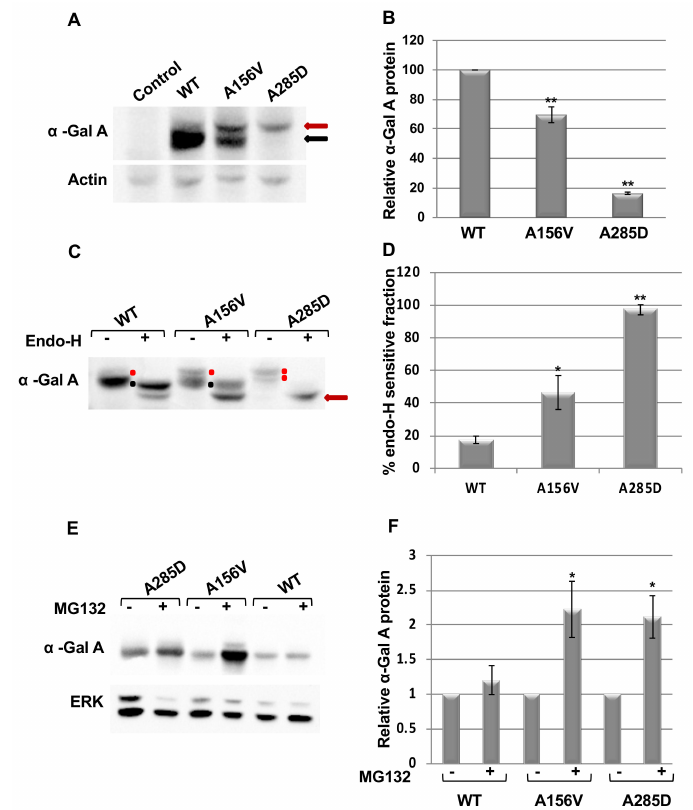
Figure 1. Alpha-Gal A expression in Drosophila melanogaster . ( A ) Lysates prepared from 15 day old flies were subjected to sodium dodecyl sulphate polyacrylamise gel electrophoresis (SDS–PAGE) and interaction with anti-Myc antibody, to identify α -Gal A and anti actin antibodies, as a loading control. The red arrow indicates the higher molecular weight, endoplasmic reticulum (ER) retained fraction of the protein; the black arrow indicates the lower molecular weight lysosomal fraction of the protein. ( B ) Quantification of results as seen in A of three independent experiments (mean ± standard error of mean (SEM)). To quantify the results, α -Gal A intensity in each lane was divided by that of actin in the same lane, and the number obtained for wild type (WT) was considered to be 100. Statistical analysis included one-way ANOVA followed by one-sample t-test. ( C ) Lysates prepared as in A were treated with endo-H and analyzed by Western blotting. The red dot indicates the higher molecular weight, ER retained fraction of the protein before endo-H treatment; the red arrow indicates the ER retained fraction of the protein after endo-H treatment; and the black dot marks the lower molecular weight, endo-H resistant lysosomal fraction of the protein. ( D ) Quantification of results as shown in ( C ). The amount of endo-H sensitive α -Gal A fraction in each treated lane was divided by the total amount of protein in the same lane. The results are the mean ± SEM of five independent experiments. Statistical analysis included one-way ANOVA followed by post-hoc Dunnett test. ( E ) Twenty-four hours after transfection of HEK293T cells with pcDNA4-MycHis- α -Gal A plasmids (human WT, A156V, A285D), they were treated with 25 µ M MG132 for 20 h, and their lysates were subjected to Western blotting and interaction with anti-Myc antibody, to identify α -Gal A and anti ERK antibodies, as a loading control. ( F ) Quantification of results as shown in ( E ). To quantify the results, α -Gal A intensity in each lane was divided by that of ERK in the same lane, and the number obtained for every variant without treatment was considered to be 1. The results are the mean ± SEM of three independent experiments. Statistical analysis included one-sample t-test. Significance: * p < 0.05; ** p < 0.01. The expression of the α -Gal A mutant variants was under the daughterless GAL4 driver